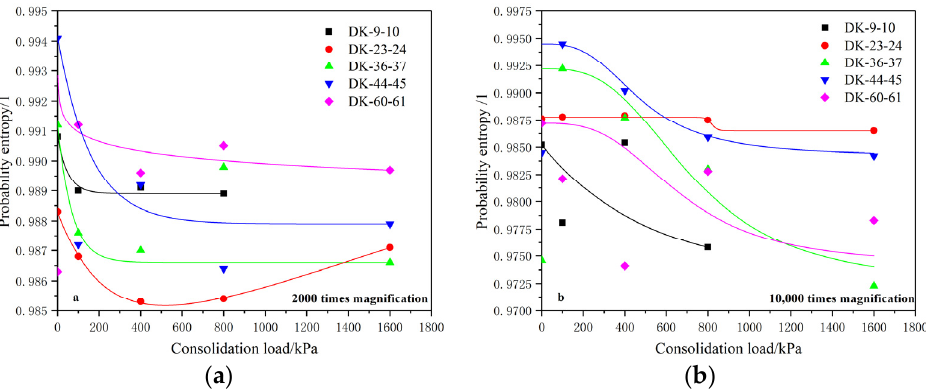
Figure 8. Relationship between the element probability entropy and consolidation load. ( a ) 2000 times magnification; ( b ) 10,000 times magnification.